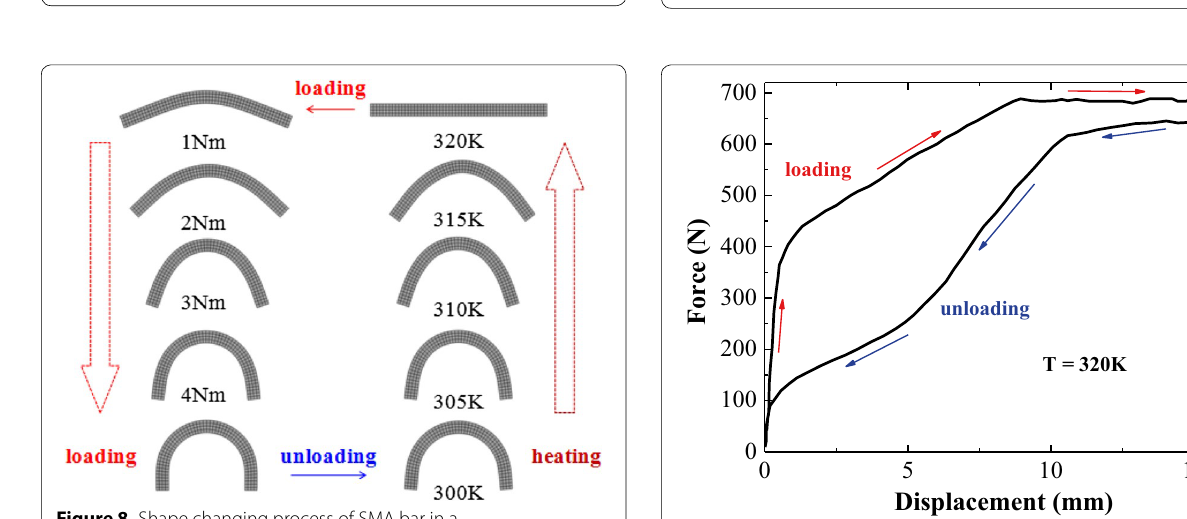
Figure 9 A deformation mechanism of a SMA cirque